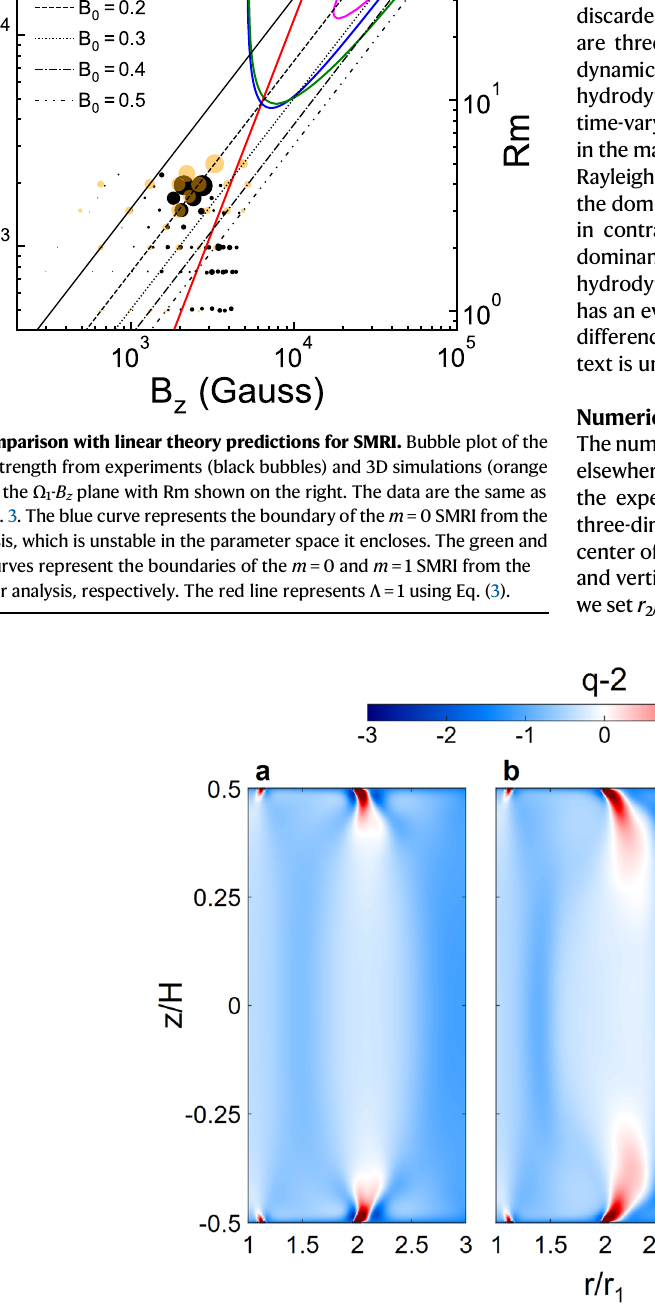
Fig.9|Characterizationof fl owshear. Shearpro fi le q − 2from3Dsimulationsat fi xedRm=4anddifferentvaluesof B 0 and Λ :( a ) B 0 = Λ =0(hydrodynamic),( b ) B 0 =0.2 and Λ =0.41, ( c ) B 0 =0.4 and Λ =1.64. Calculations are based on time and azimuthal averages in the hydrodynamic or MHD steady state.